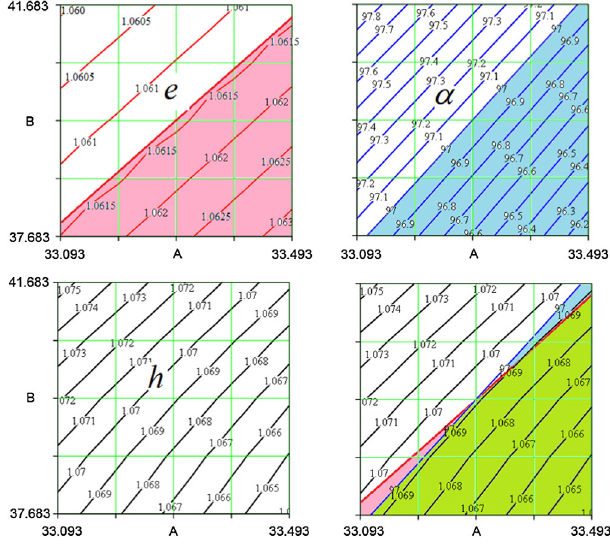
FIG. 11. Map for the optimized SNS cavity. a ¼ 11 . 387 mm, b ¼ 21 . 009